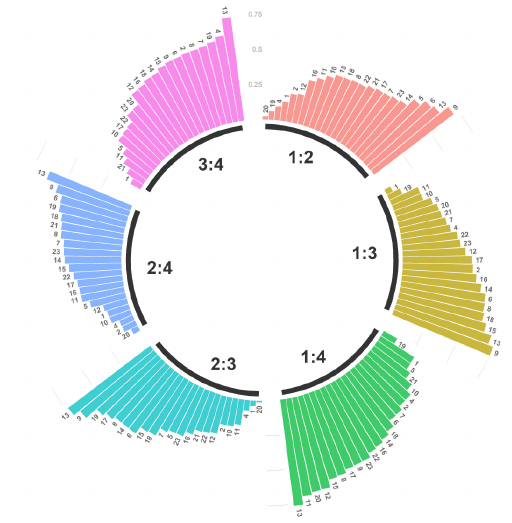
Figure 4. A circular bar chart of ordered V-measures for every unique data set combination, not including